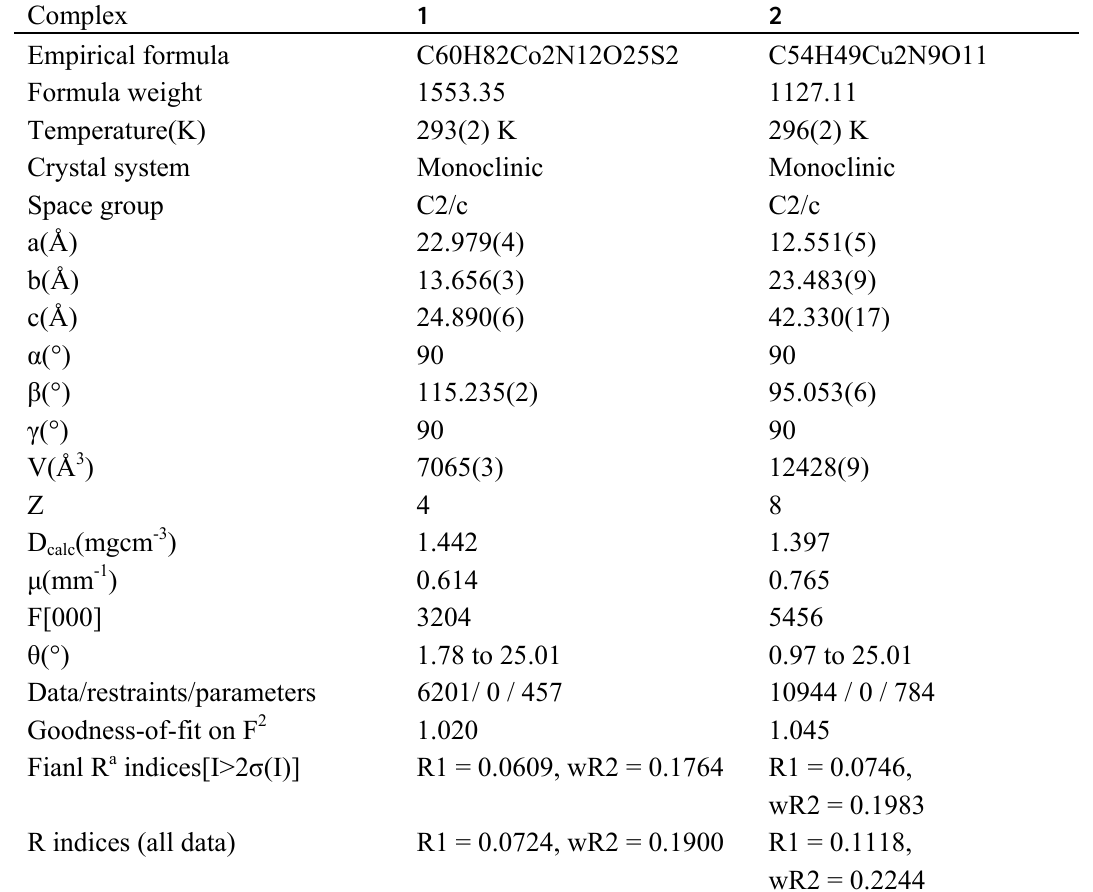
Table 1. Crystal data and structure refinements for complexes 1-2 .